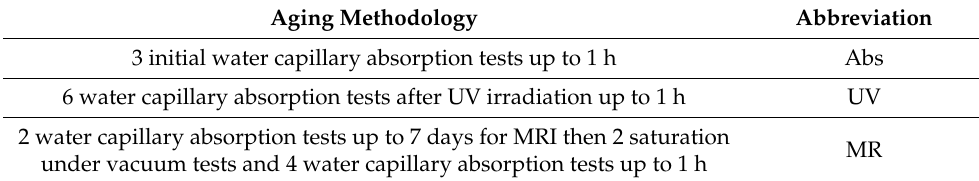
Table 2. Conditions adopted for the aging through wet-dry